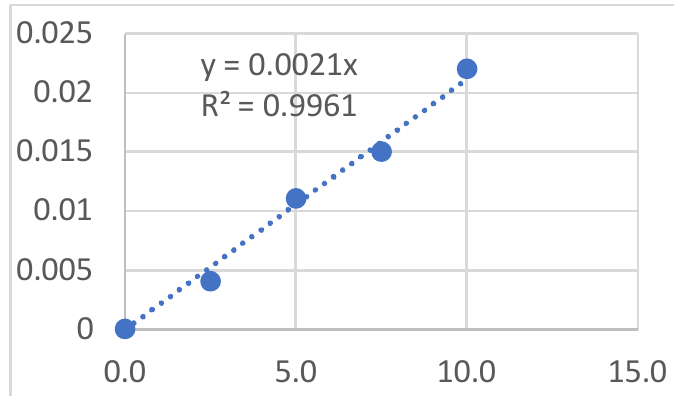
Figure 1. Pb calibration graphs